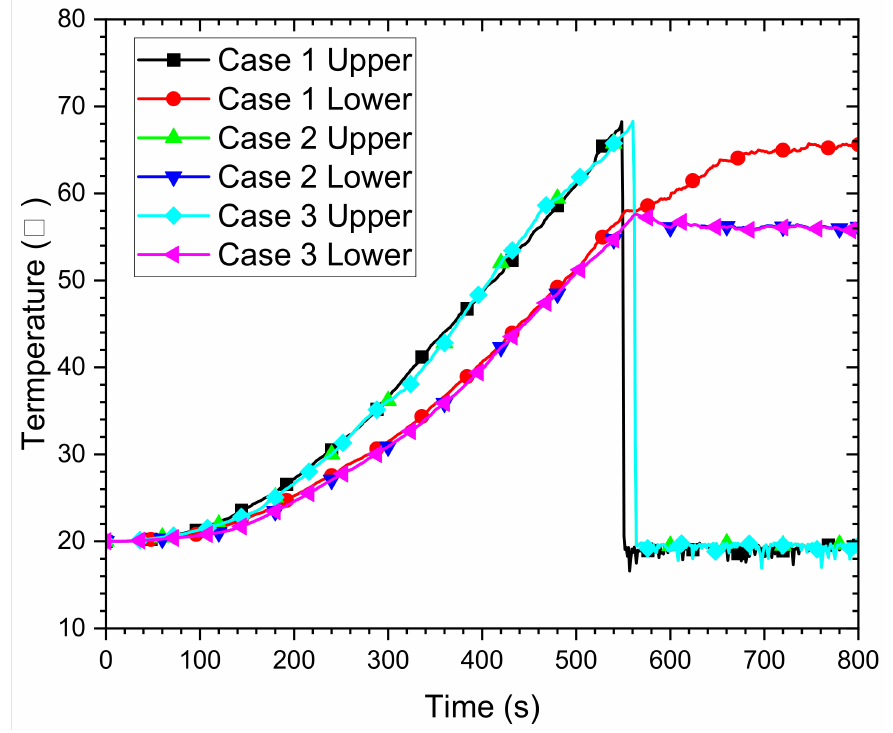
Figure 6. Temperature variation at the sprinkler